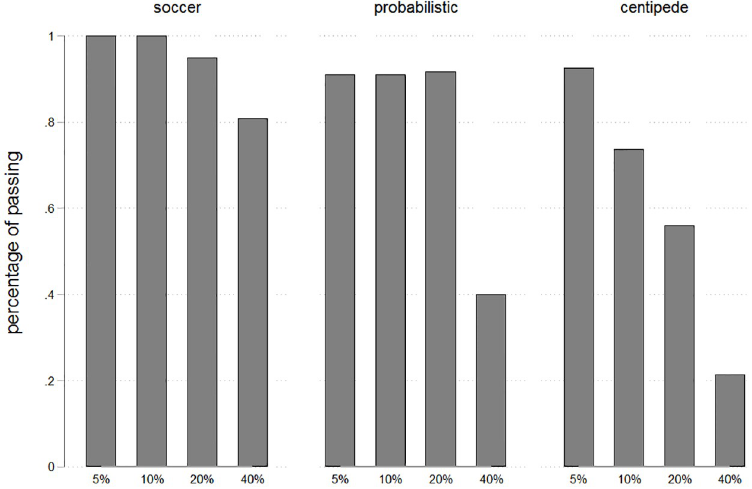
Fig 4. Percentages of passing by treatment. Percentages denote the share of participants who decide to pass among all those who have reached a given stage. As can be seen, percentages are highest in “Soccer”, intermediate in “Probabilistic” and lowest in